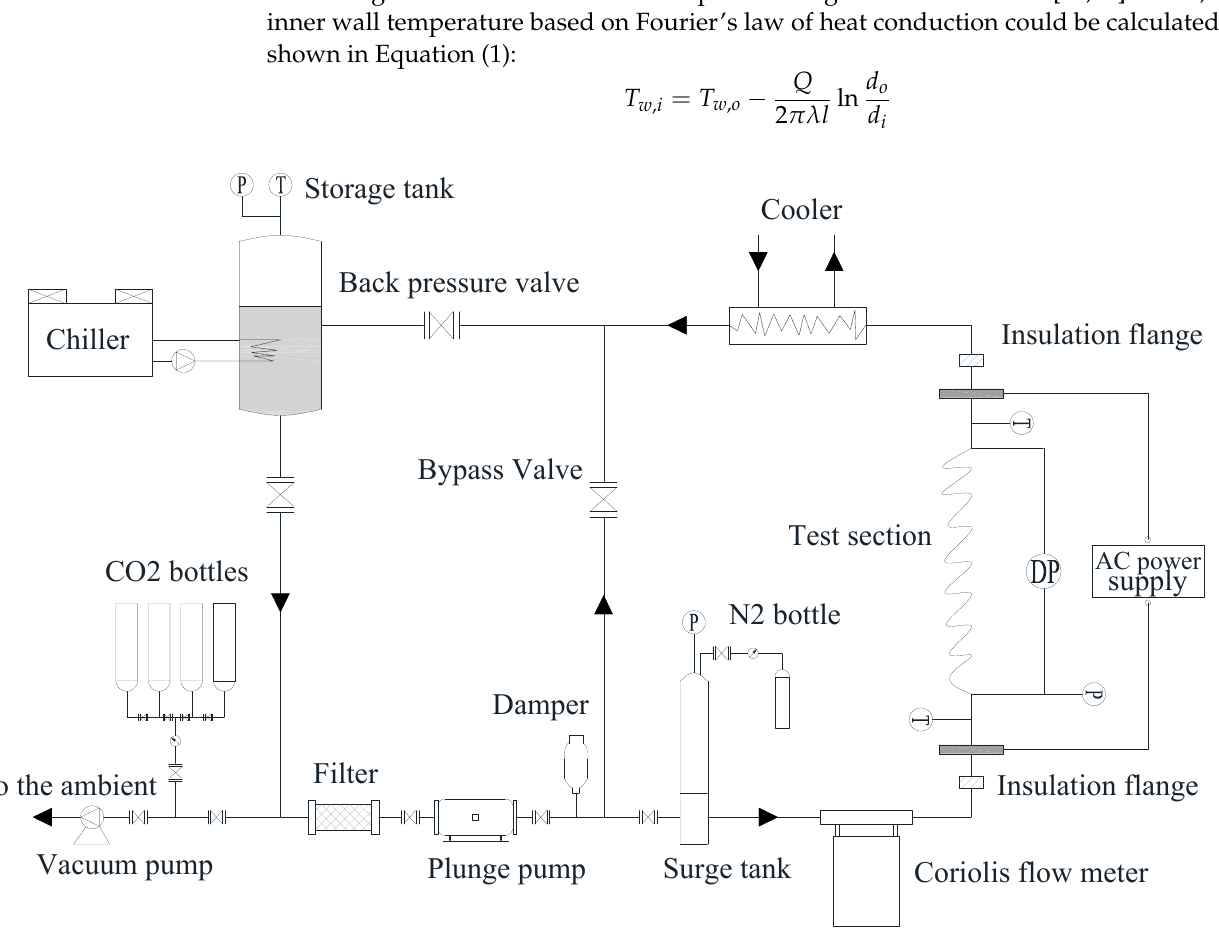
Figure 3. Schematic diagram of the experimental test facility for the investigation of the heat transfer of supercritical CO 2 in helically coiled tube [49].